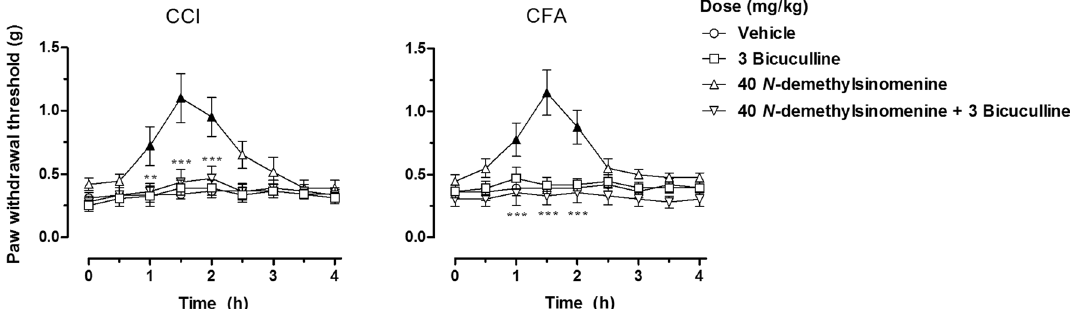
Figure 4. Pretreatment with GABA A receptor antagonists bicuculline blocked the anti-allodynic effects of N -demethylsinomenine (40 mg/kg) in CCI-operated (left) and CFA-treated (right) mice. Filled black symbols indicated data significantly different from the vehicle-treated group ( P < 0.05). ** P < 0.01, *** P < 0.001 indicated significant differences between N -demethylsinomenine (40 mg/kg) alone and in combination with bicuculline group (n = 8 per